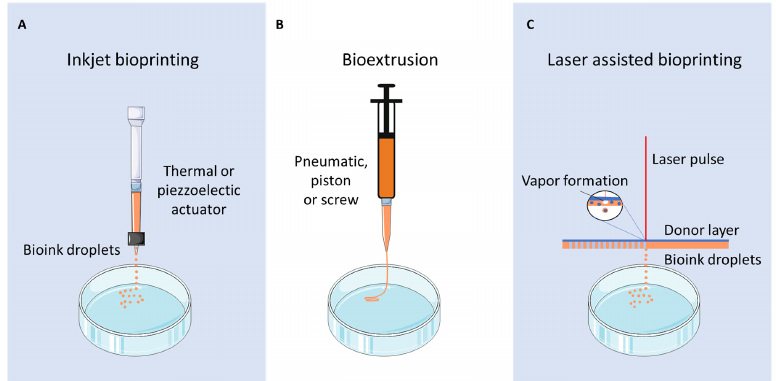
Figure 2. Different bioprinting strategies are available for cartilage tissue engineering. ( A ) Inkjet bioprinting based on the deposition of droplets formed by a thermal or piezoelectric actuator on a support. ( B ) Bioextrusion (or microextrusion) based on the extrusion of a continuous bioink filament through a printing needle driven by a screw, pneumatic or a piston. ( C ) Laser-assisted